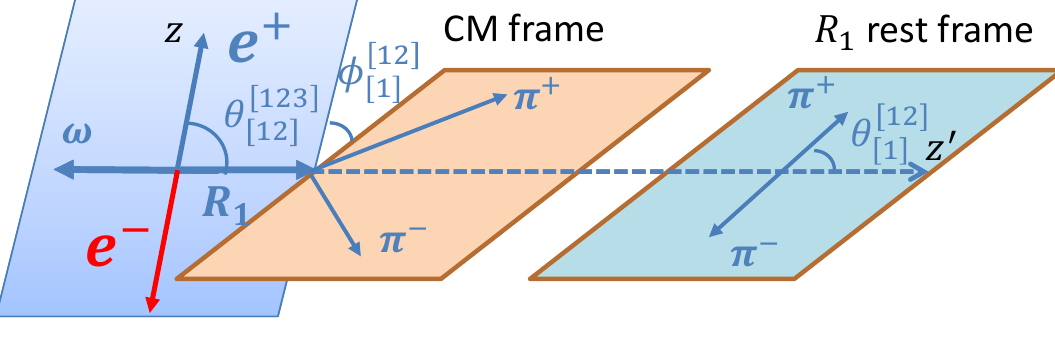
Figure 2 . Helicity rotation angles defined for the process e + e − → R 1 ω, R 1 → π + π − . Processes Helicity angles Amplitudes